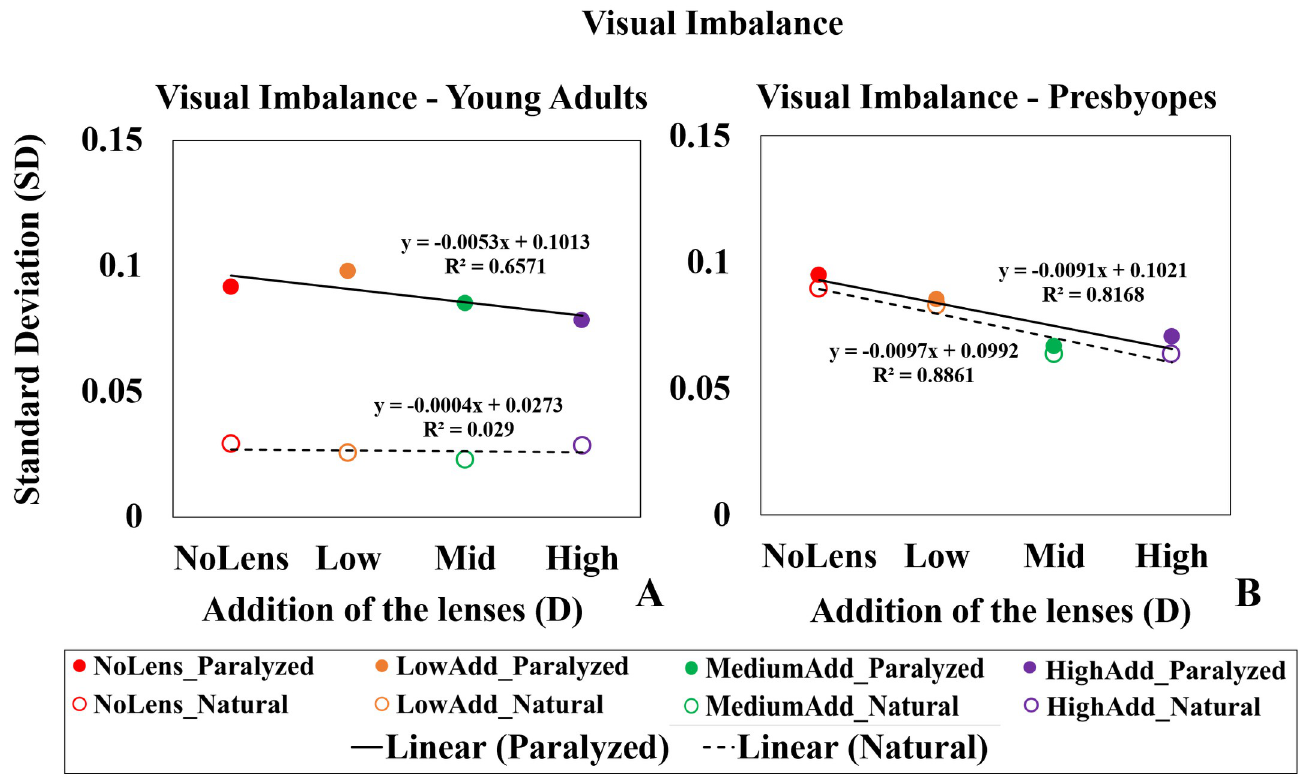
Fig 9. Visual imbalance across the VA curve. (A) young adults (B) presbyopes across paralyzed (solid symbols) and natural accommodation (open symbols) for different lenses, showing the averaged data (averaged across all subjects). (Lens condition identified by color—Red: NoLens; Orange: LowAdd; Green: MediumAdd; Purple: HighAdd). Regression lines shown as black solid lines for paralyzed condition and dashed lines for natural accommodation condition.